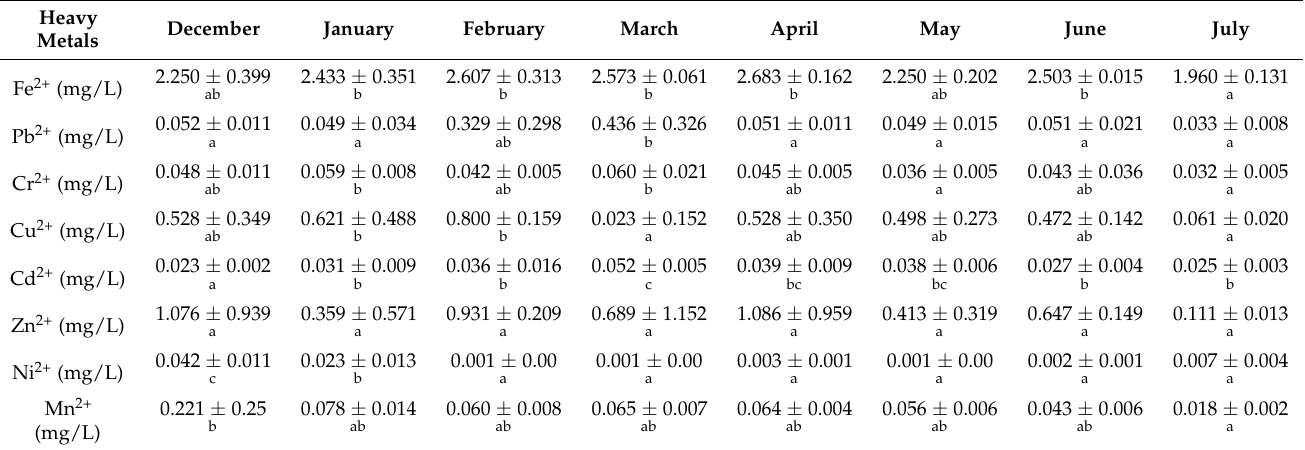
Table 2. Summary of mean heavy metals ion concentration in surface water of Ogbor